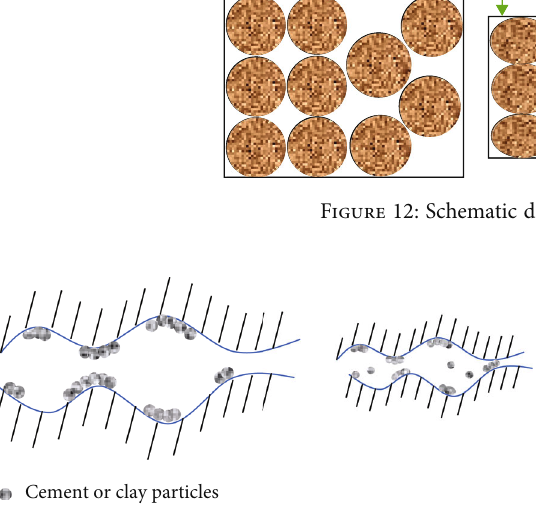
Figure 13: Schematic diagram of deformation, fragmentation, and migration of cement or clay particles.